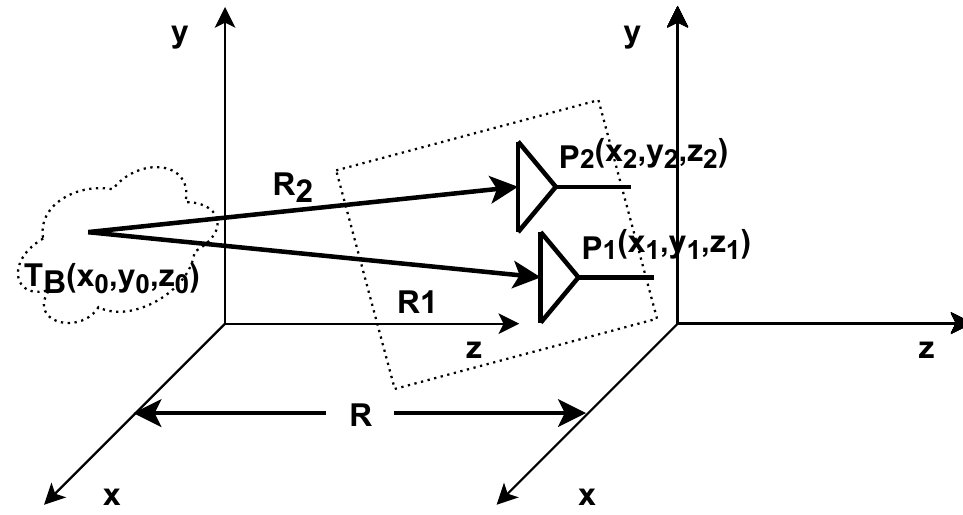
Figure 2. Schematic of near-field target radiation signal